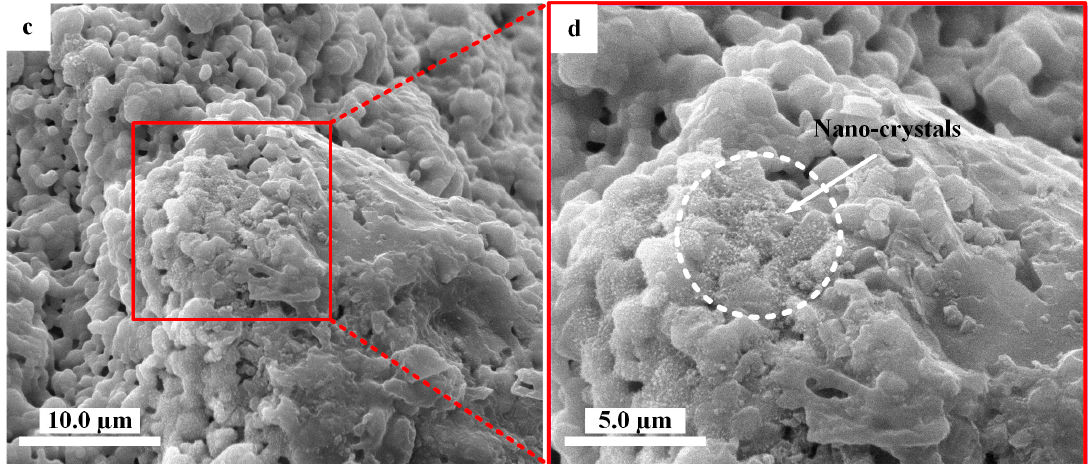
Figure 4. SEM photographs showing morphologies on HA scaffolds with the assistance of hydrothermal conditions. ( a ) Microspheres grown on a Cu 3 -HA scaffold; ( b ) micro/nano-structured surface with flower-like crystals on Cu 5 -HA scaffolds; and ( c , d ) nano-structured surface on Cu 7 -HA scaffolds.